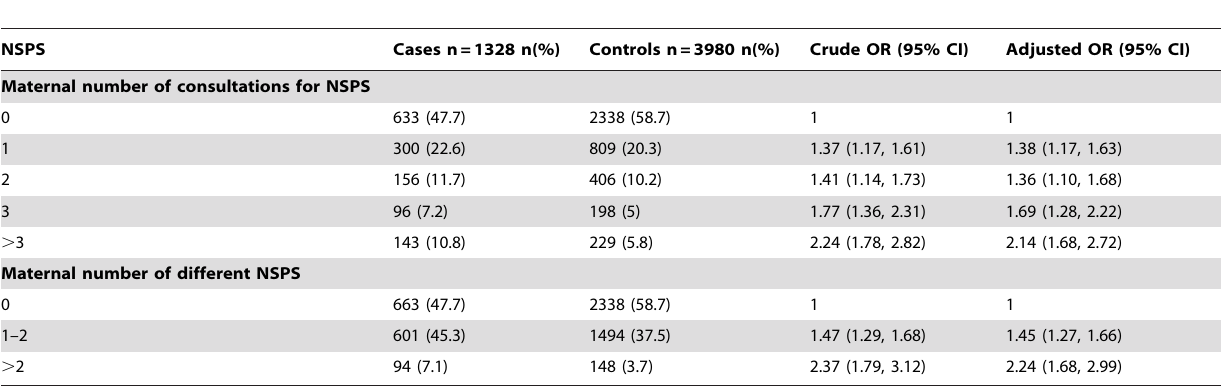
Table 5. Associations between number of consultations for NSPS and number of different NSPS in mother and child consultation for